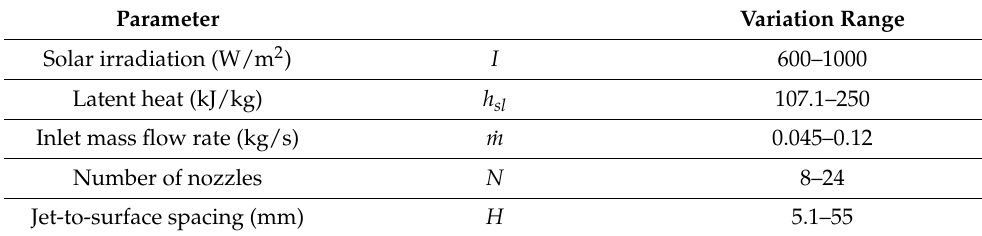
Table 3. The variation range of important